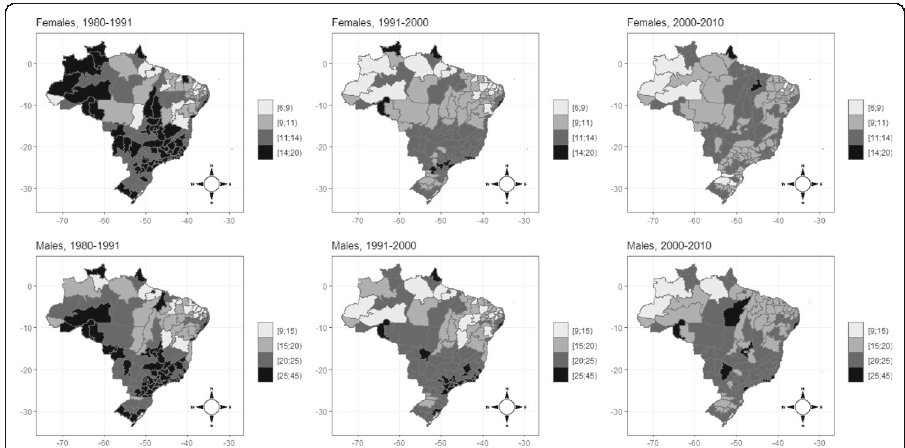
Fig. 4 Evolution of adult mortality ( 45 q 15 ) by sex and mesoregions in Brail, 1980 – 2010. Source: IBGE (1980, 1991, 2000 and 2010) and DATASUS